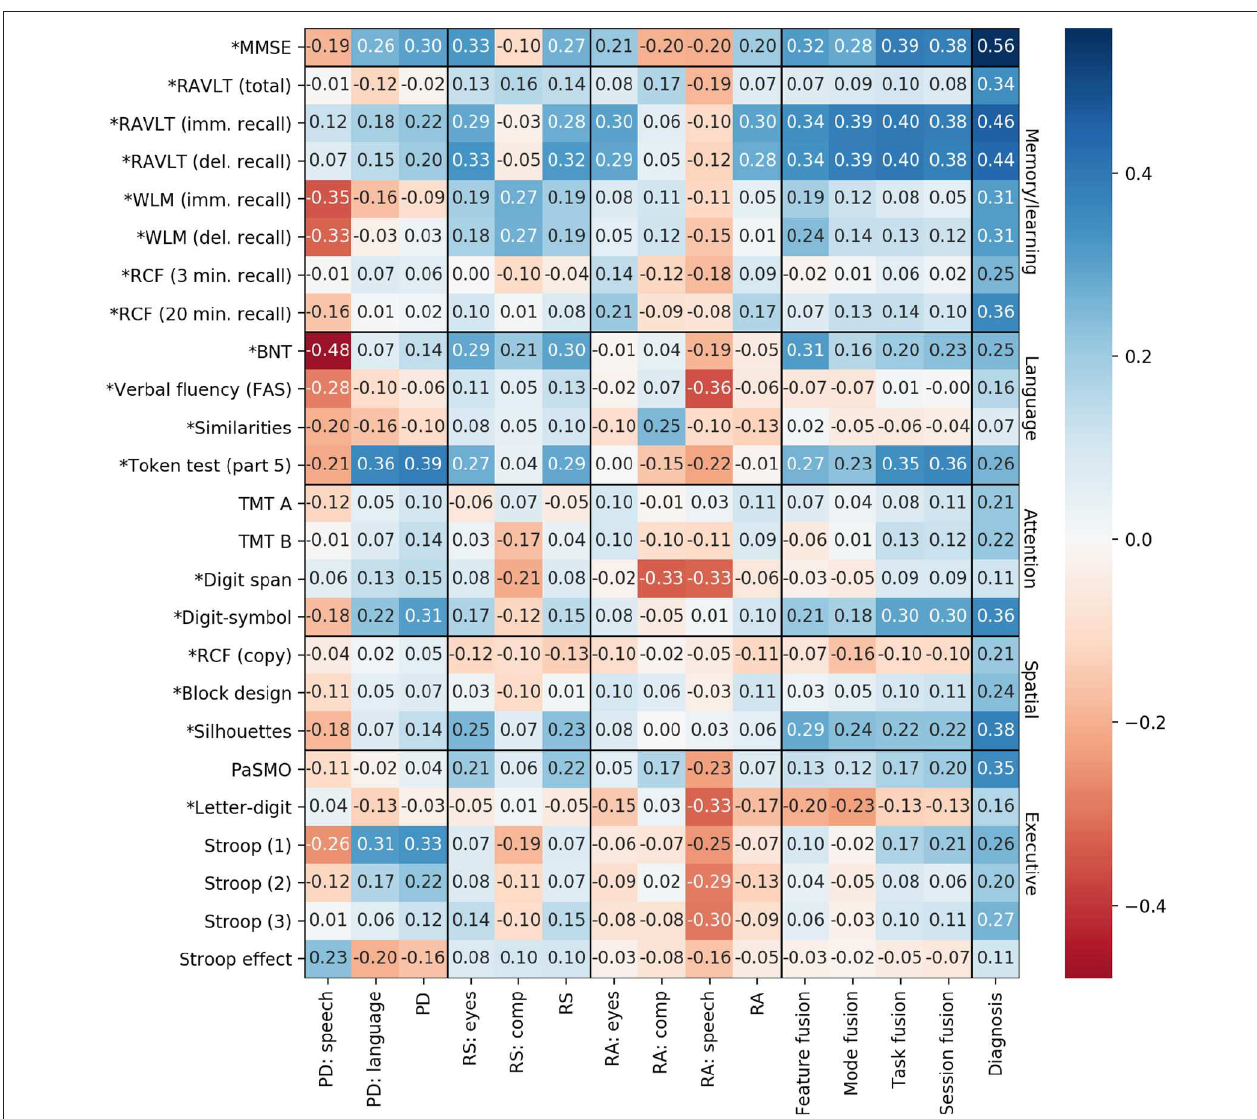
FIGURE 6 | Spearman correlations between classifier predictions and neuropsychological test scores. PD, picture description; RS, reading silently; RA, reading aloud. Asterisks indicate the sign has been flipped so that all test scores correlate positively with